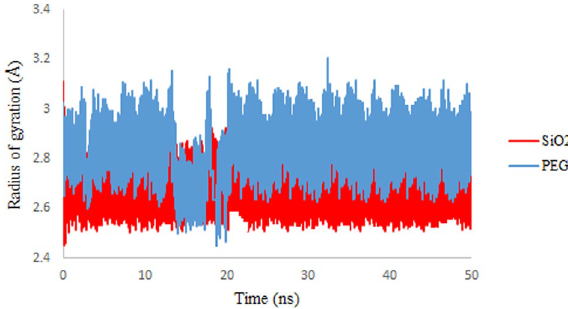
Figure 5. Rg values of 3TC adsorbed on SiO 2 (red) and PEG (blue) during the simulation time.